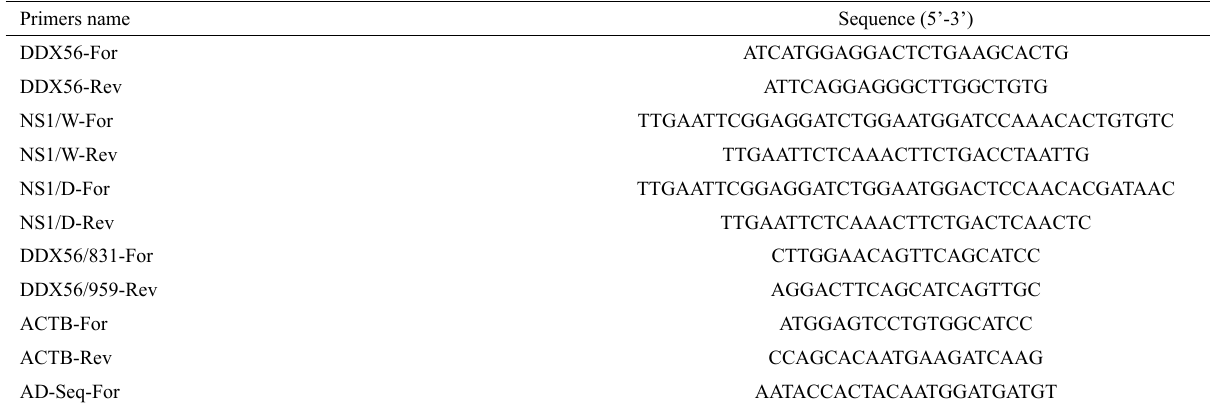
Table 1 – Oligonucleotide primers used in this